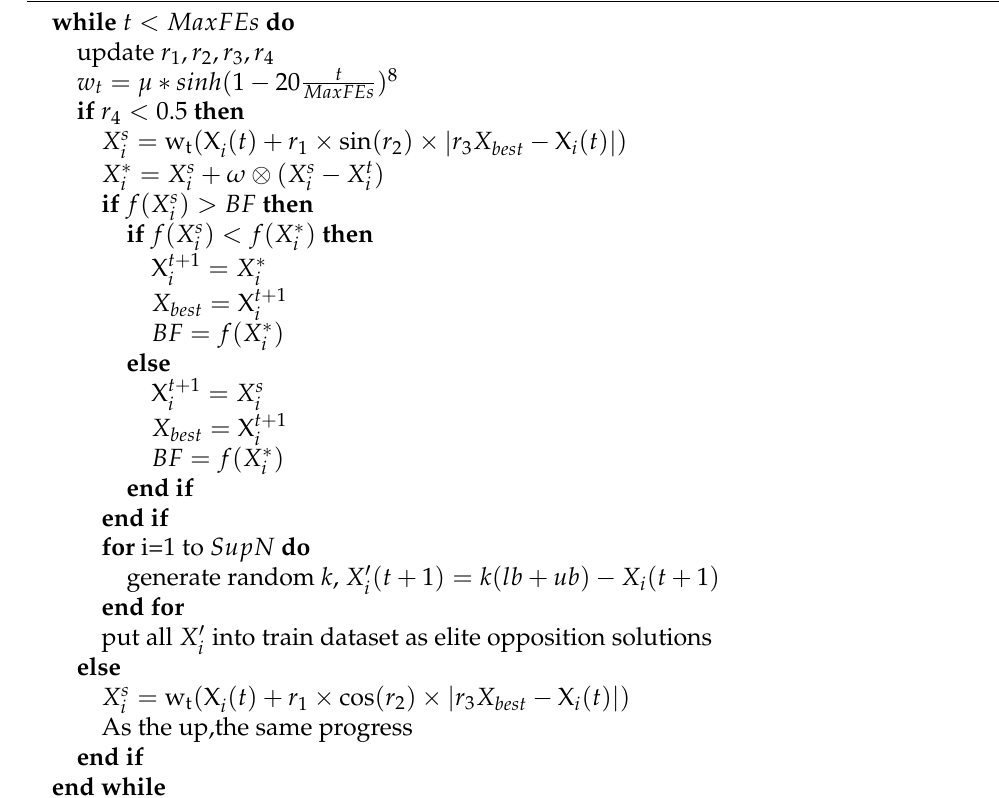
Algorithm 1 The hybrid